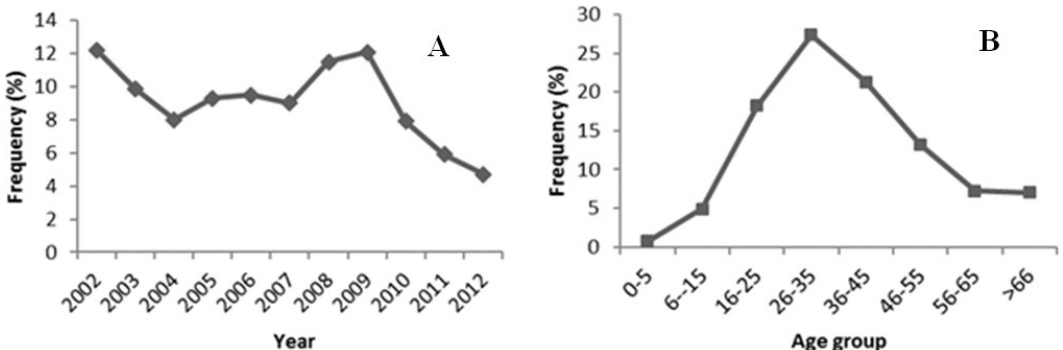
From the 7894 serum samples analyzed, more than half of the patients (60.4%) had HAV immunity and only 0.3% of patients were recently infected with HAV (Figure 2). About 30% of the patients did not show immunity against